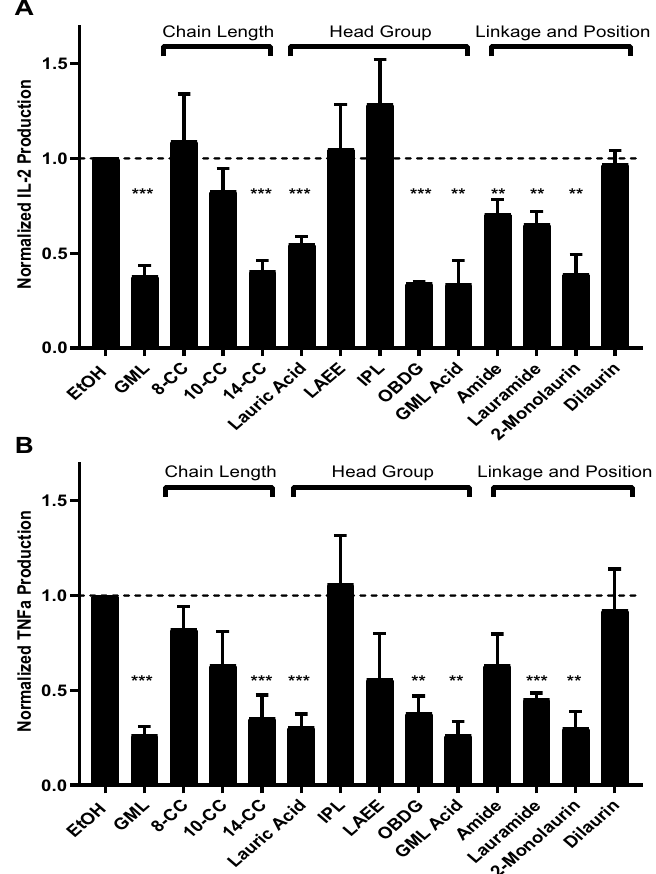
Figure 6. Chain length, head group polarity, and position affect the ability of GML to inhibit cytokine production. Rested human APBTs were treated overnight with 10 ug/mL of designated compound in serum free RPMI. Supernatants were collected and the release of ( A ) IL-2 and ( B ) TNF-α were assessed by ELISA. Values for each treatment were normalized to EtOH control to account for donor variability. Data for each compound was compiled from 3 to 5 donors. Dashed line indicates EtOH control cytokine production. One-sample T-test analysis was used to determine statistical significance. (* p < 0.05, ** p < 0.01, *** p < 0.001).